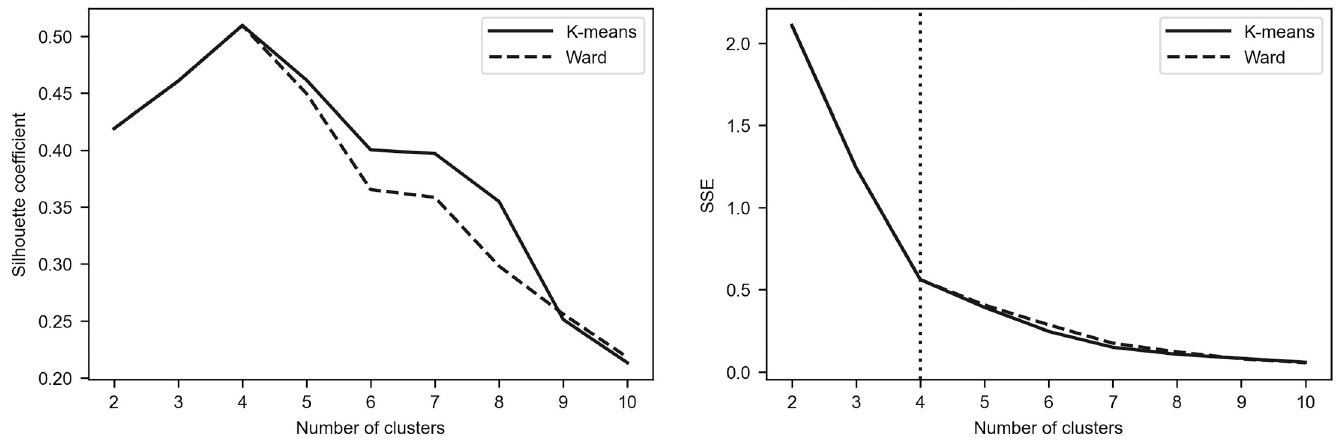
Fig 2. Silhouette coefficients and elbow curve–Period_1.